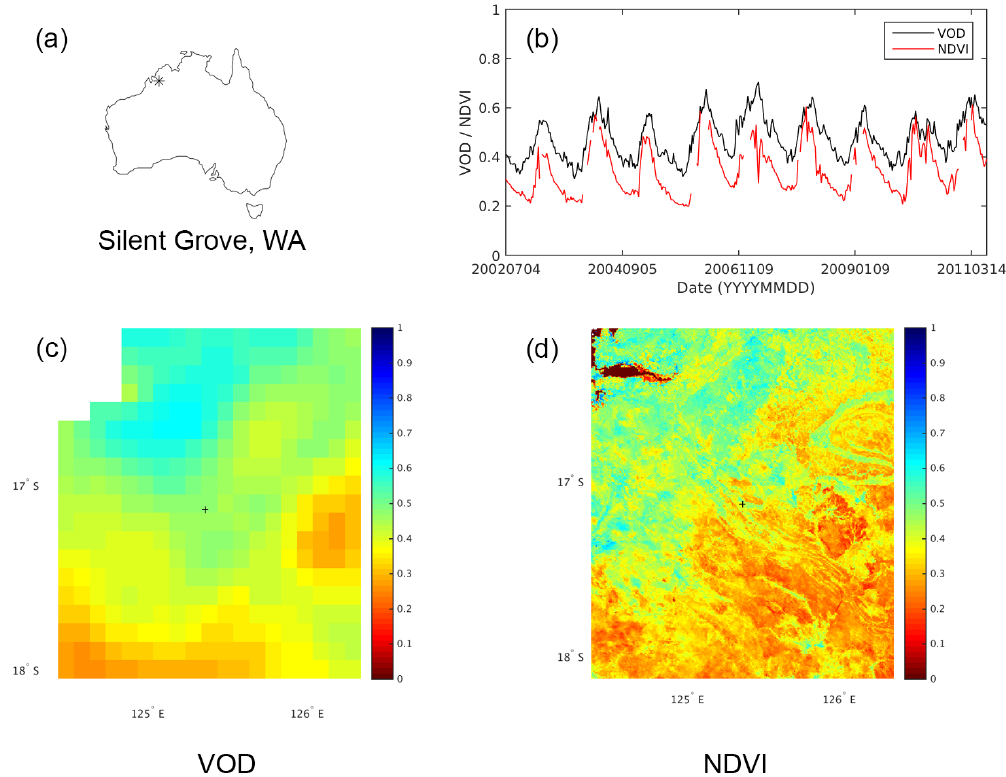
Figure 1. Example vegetation optical depth (VOD) and normalised difference vegetation index (NDVI) time series (b) and spatial maps (c) for VOD and (d) for NDVI, at Silent Grove, WA (17.131 ◦ S, 125.374 ◦ E). The star ( ∗ ) indicates the location of the time series on a map of Australia (a) .